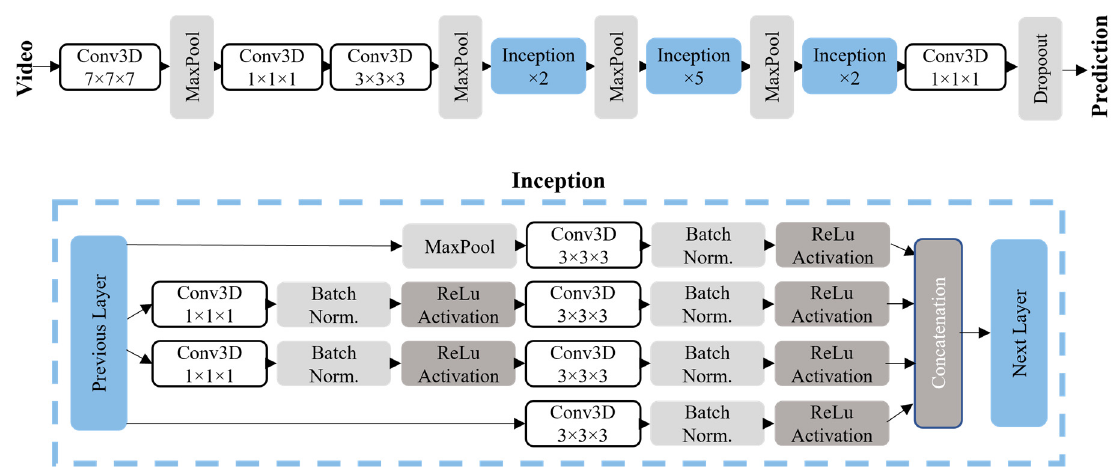
Figure 3. Model architecture for the I3D model, proposed by Carreira et al. The convolutional layers are all followed by batch normalization and ReLu activation. The final prediction uses SoftMax activation.